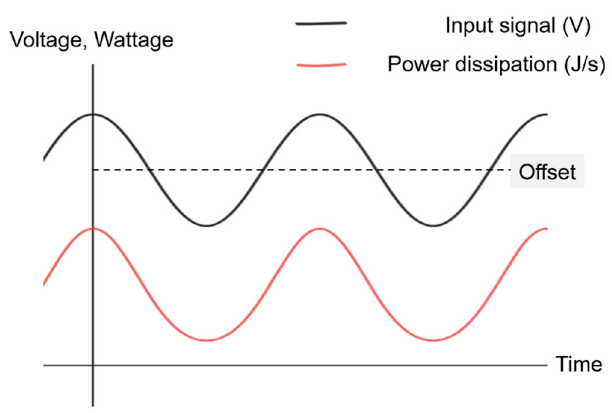
Figure 3. Illustration of input voltage signal (AC + DC offset) of the HR (black line) that result in a power dissipation (red line) which is in-phase with the input signal.